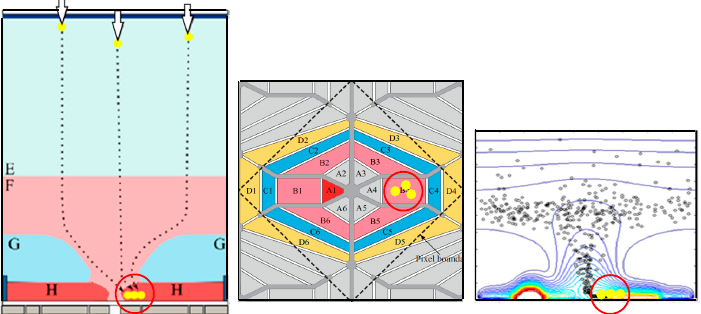
Figure 1. A pixel of the BSI MCG image sensor. Left : cross section; center : plane structure